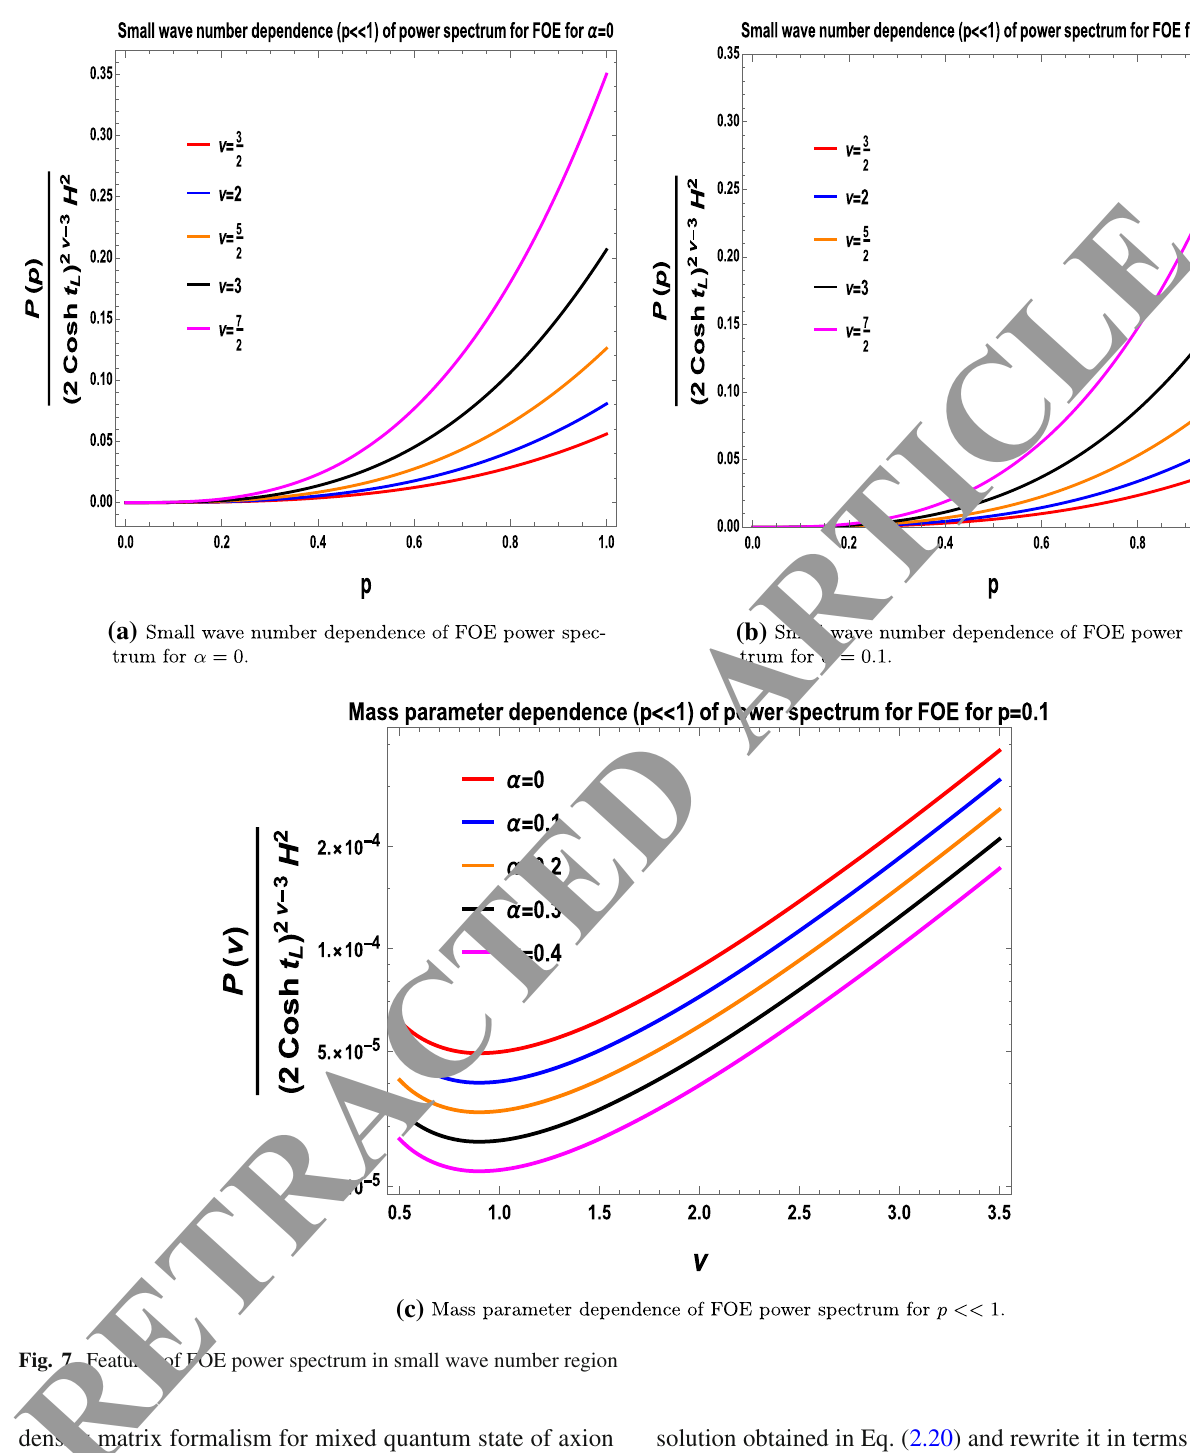
density matrix formalism for mixed quantum state of axion in de Sitter hyperbolic open